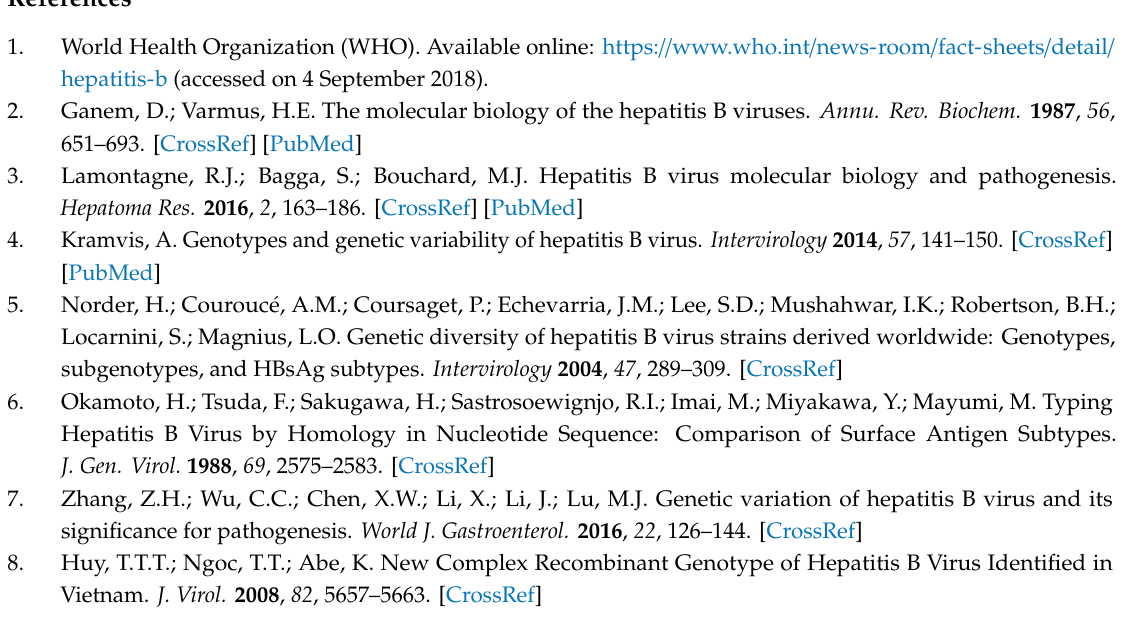
Figure S1: Genome alignment of representative sequences of HBV used to make the phylogenetic inference, Figure S2: Alignment of representative sequences of HBV B region used to make the phylogenetic inference, Figure S3: Broad size fragments from libraries after the Nextera XT procedure, Figure S4: Example of quality score before (A) and after (B) cleaning in library from sample